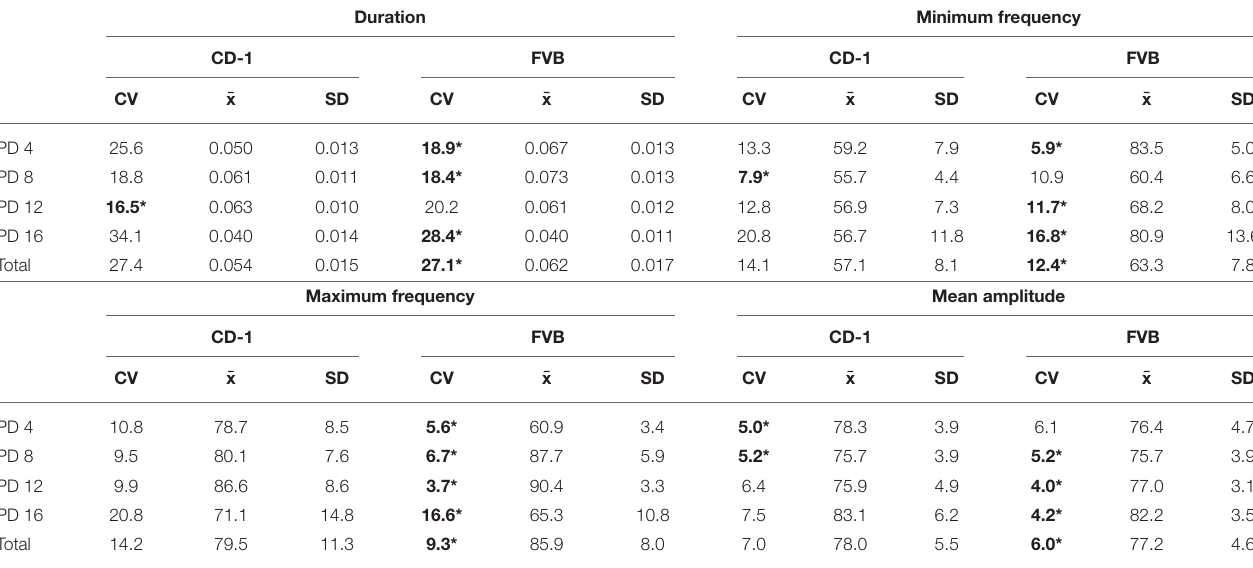
TABLE 2 | Variability in USV characteristics per day and in total between groups. Duration Minimum frequency CD-1